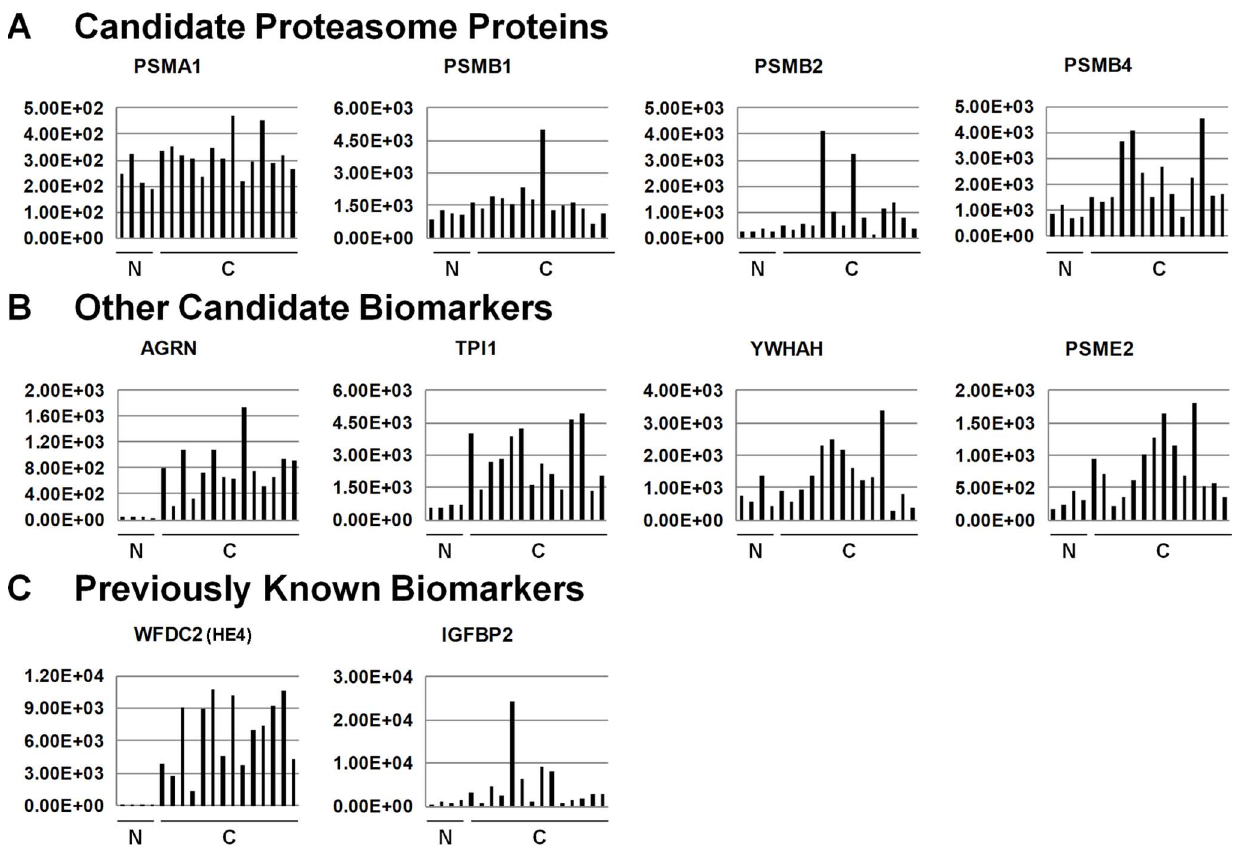
Figure 5. Gene expression of candidate biomarkers in ovarian tissues. Gene expression levels for normal ovary tissue (N; n=4) and papillary serous ovarian carcinoma primary tumor samples (C, n=14) are shown. (A) Representative candidate proteasome proteins. (B) Representative novel proteins identified in the xenograft mouse plasma. (C) Two previously reported ovarian cancer biomarkers that were identified in the current dataset. Microarray hybridization data were processed and scaled as previously described. [36,37] Data were extracted from www.BioGPS.org.